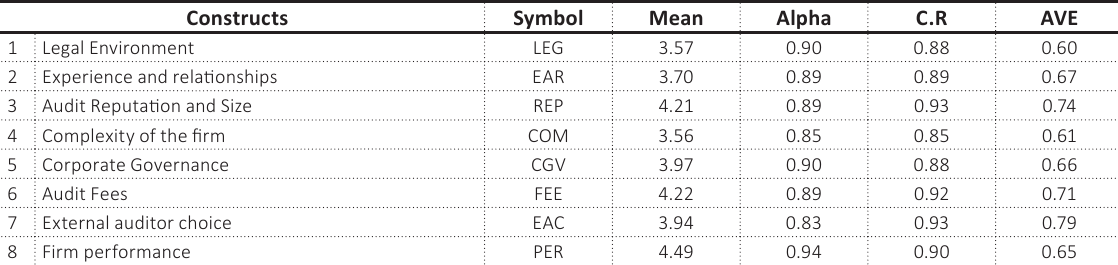
Table 3. Reliability and validity statistics